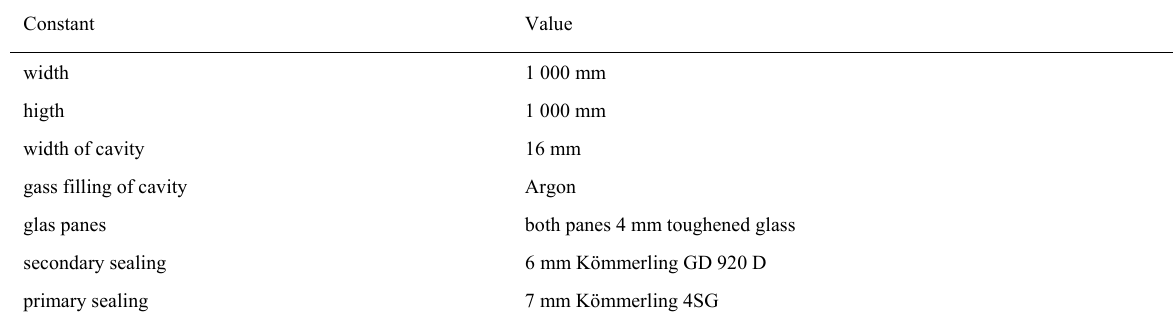
Table 2: IGU Data for the torqued